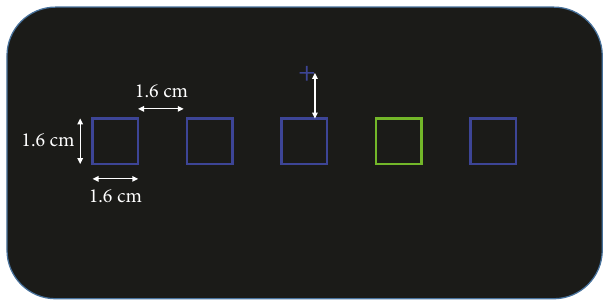
Figure 5: Five box task